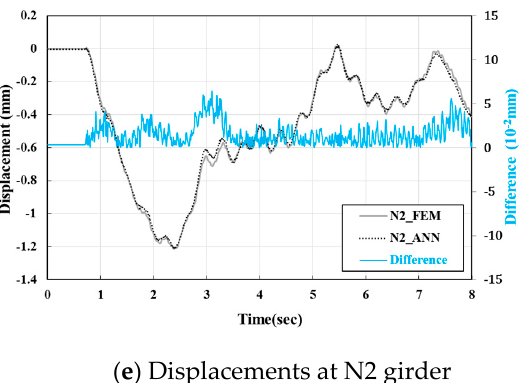
Figure 12. Test results at midpoint of girder for 60 km/h.